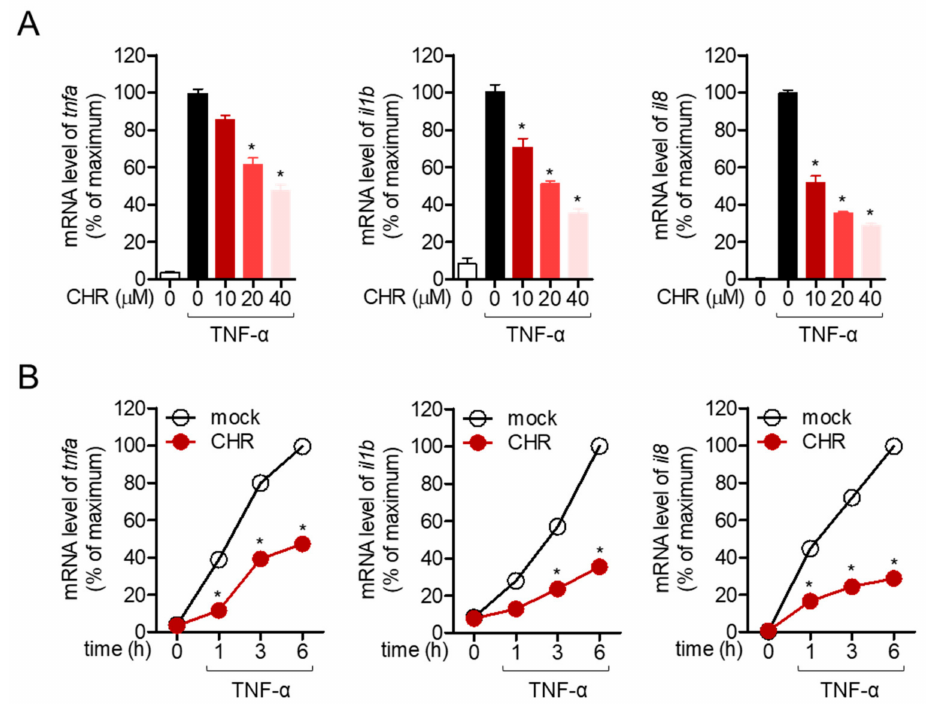
Figure 2. Pre-treatment with chrysophanol inhibits the expression of pro-inflammatory cytokines in stimulated HT-29 cells. ( A ) HT-29 cells pre-treated with the indicated concentrations (0 to 40 µ M) of chrysophanol for 1 h were stimulated with tumor necrosis factor- α (TNF- α ) (10 ng/mL) for 6 h and harvested for the isolation of mRNA. The mRNA levels of indicated genes are presented in bar graph. ( B ) HT-29 cells pre-treated with 40 µ M of chrysophanol for 1 h were stimulated with TNF- α (10 ng/mL) for the indicated time (0 to 6 h). Collected cells were lysed for mRNA isolation and the mRNA levels of the indicated genes are presented in line graph. The mean value of three experiments ± SEM is presented. * p < 0.05 compared with TNF- α -treated cells ( A ) or mock-treated cells ( B ). IL-1b; interleukin-1 beta, IL-8: